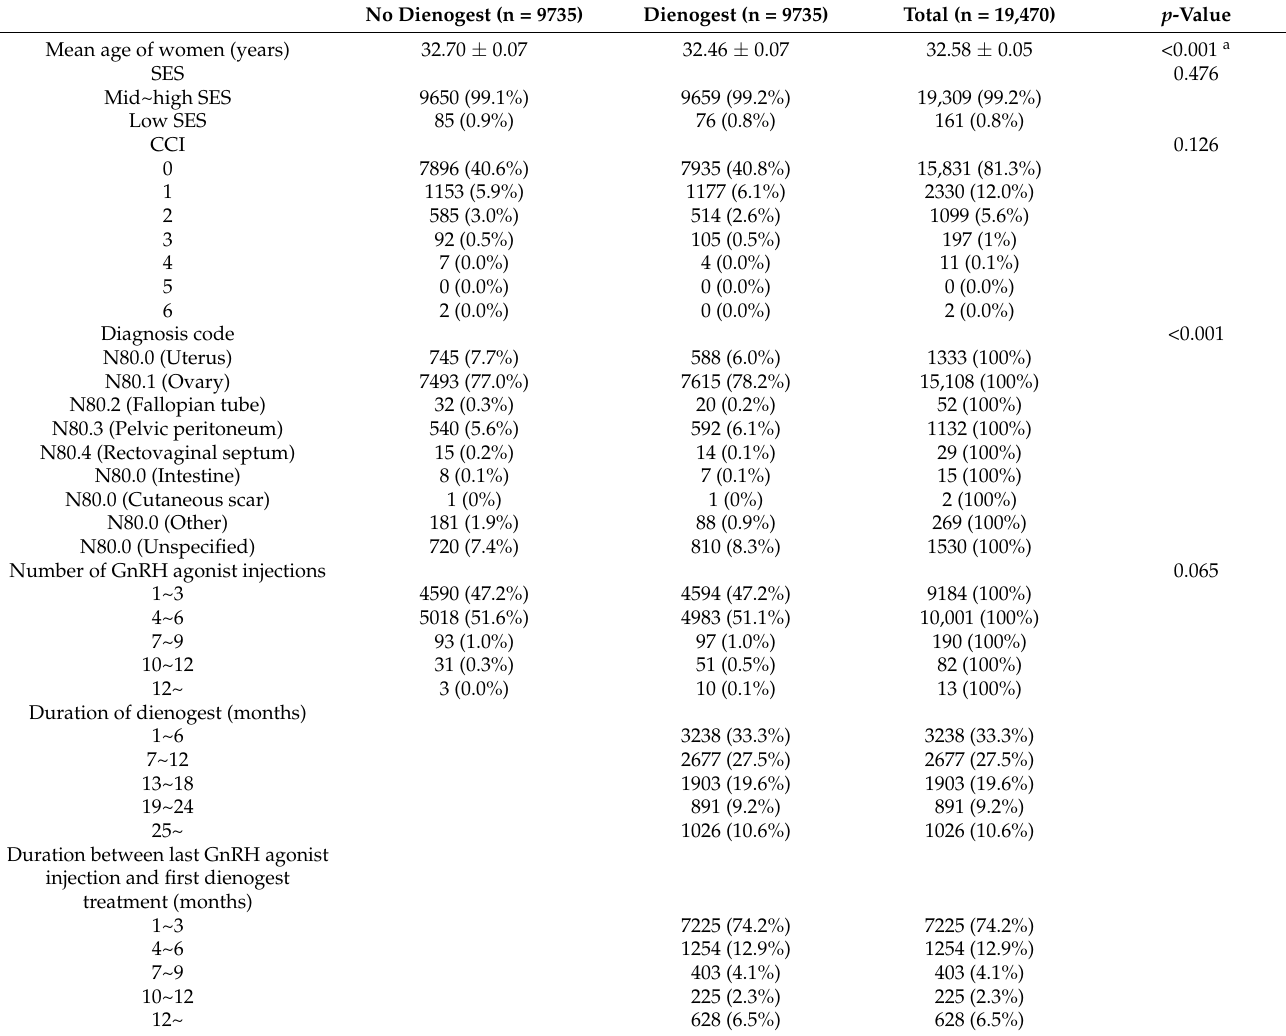
Table 2. Characteristics of the women with EMS injected with a GnRH agonist after PSM in the HIRA 2013–2018 data. No Dienogest (n = 9735) Mean age of women